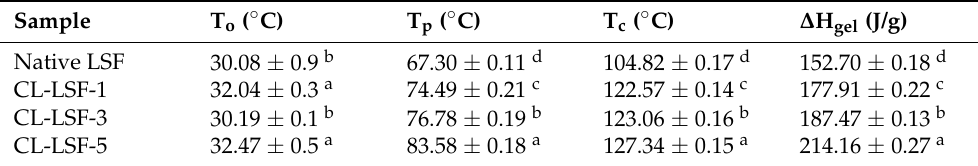
Table 5. Thermal properties of native and cross-linked lotus seed starch